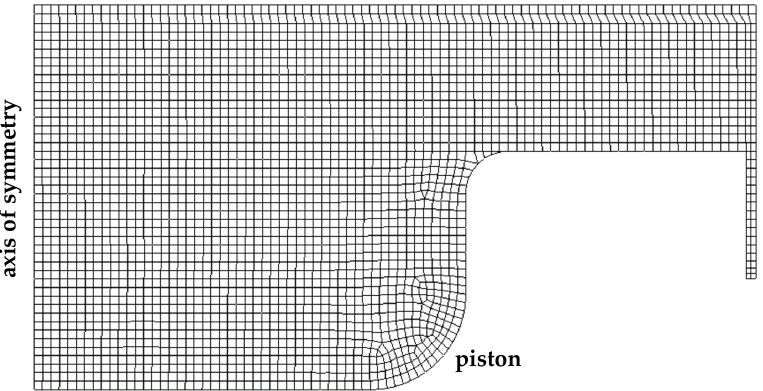
Figure 1. Computational grid for the model validation at 30 CAD BTDC.